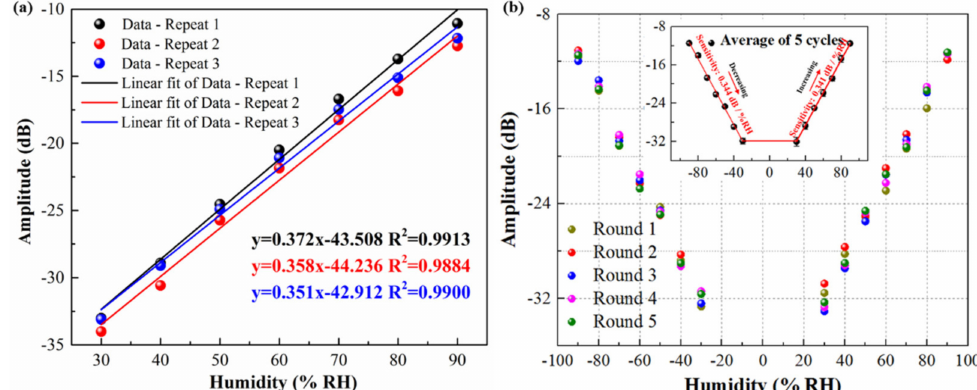
Figure 5. Repeat tests with different relative humidity. ( a ) Three repeated experimental data under increasing the relative humidity ( b ) Five cycle tests under increasing and decreasing the